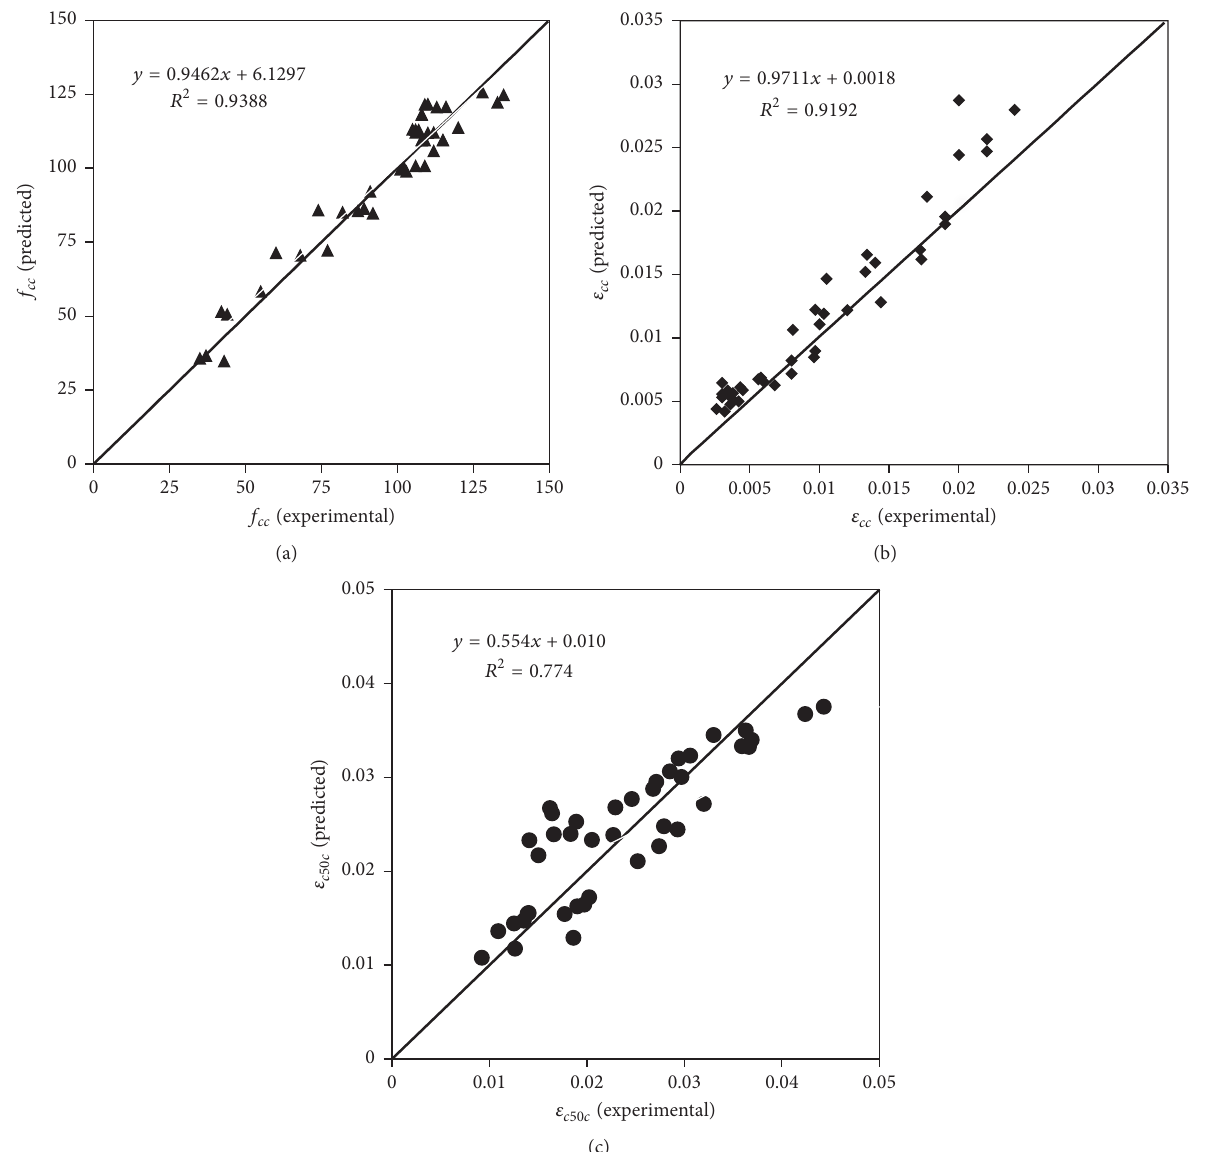
Figure 2: (a) Prediction of peak stress of confined concrete. (b) Prediction of strain in confined concrete at peak stress. (c) Prediction of postpeak strain of confined concrete at 50% of peak